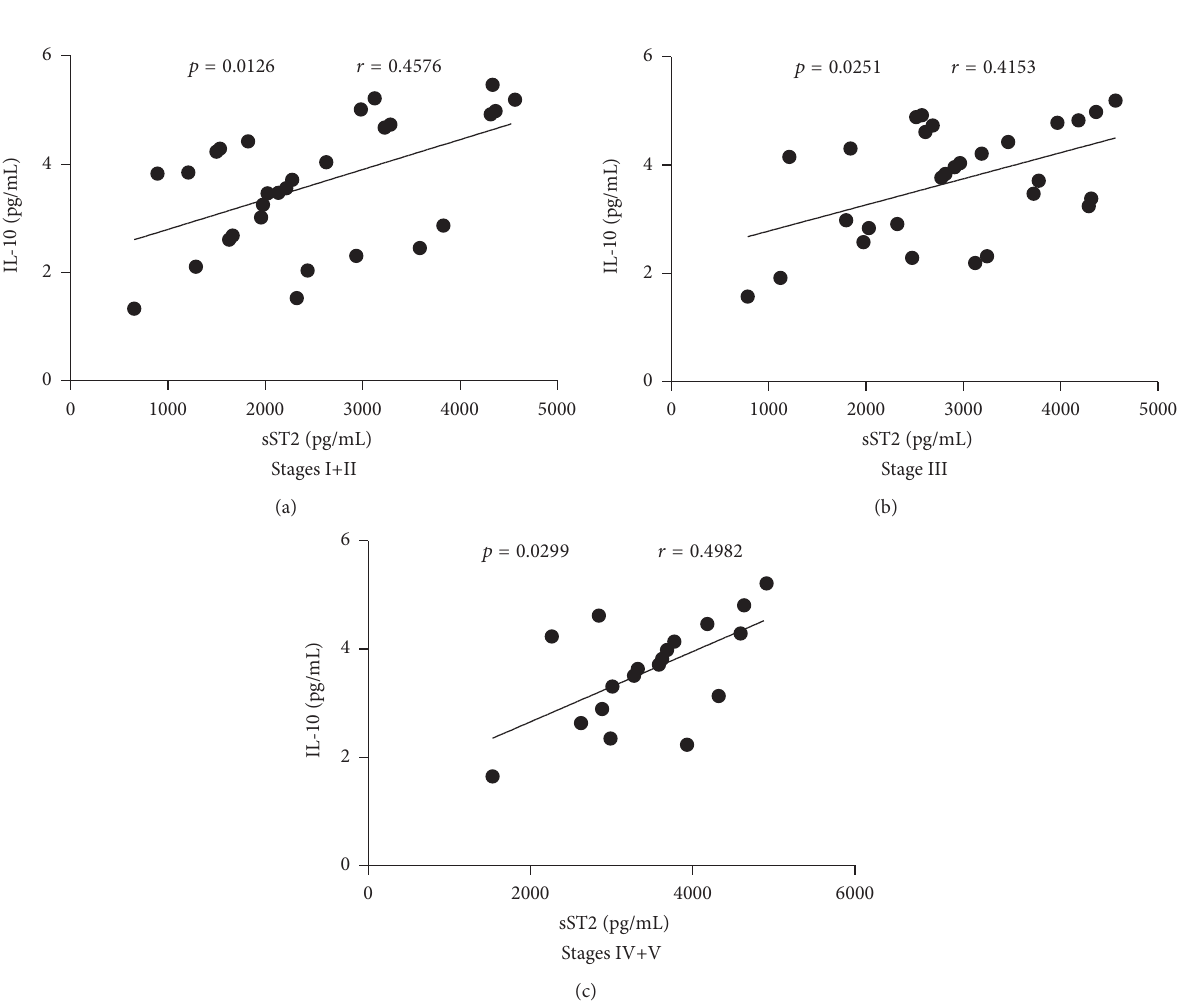
Figure 6: Correlation analysis of serum sST2 with the levels of IL-10 in different stages of IgAN patients. The potential relationships between serum sST2 and the levels of IL-10 in the different stages of IgAN patients were analyzed by Spearman correlation tests. Data shown are the mean concentration of individual subjects from two separate experiments. ((a)–(c)) Serum sST2 was positively correlated with the levels of IL-10 in Stage I+II, Stage III, and Stage IV+V of IgAN patients,